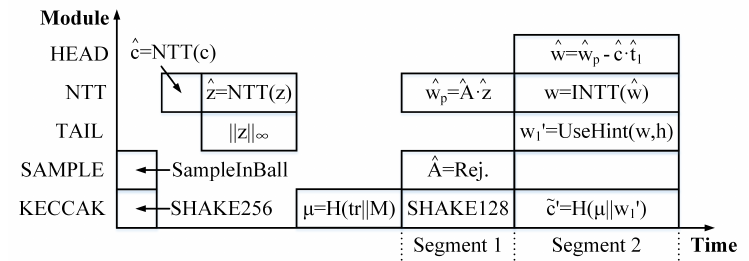
Figure 5: Segmented pipelined processing of Verify